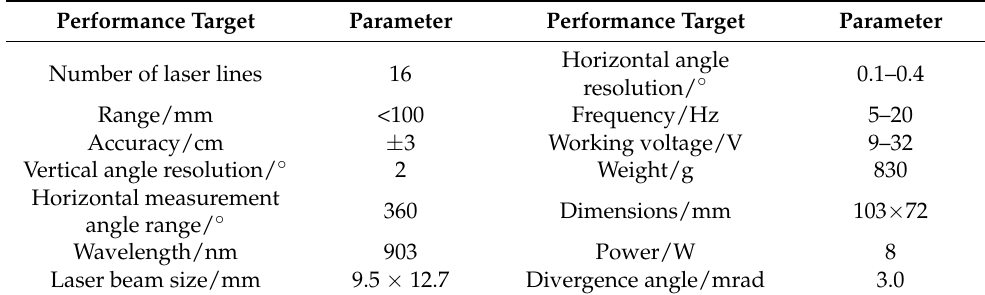
Figure 1. LiDAR measurement system: ( a ) mobile measurement terminal, ( b ) fixed reference station and ( c ) computer control part. Table 1. Main parameters of VLP-16 laser